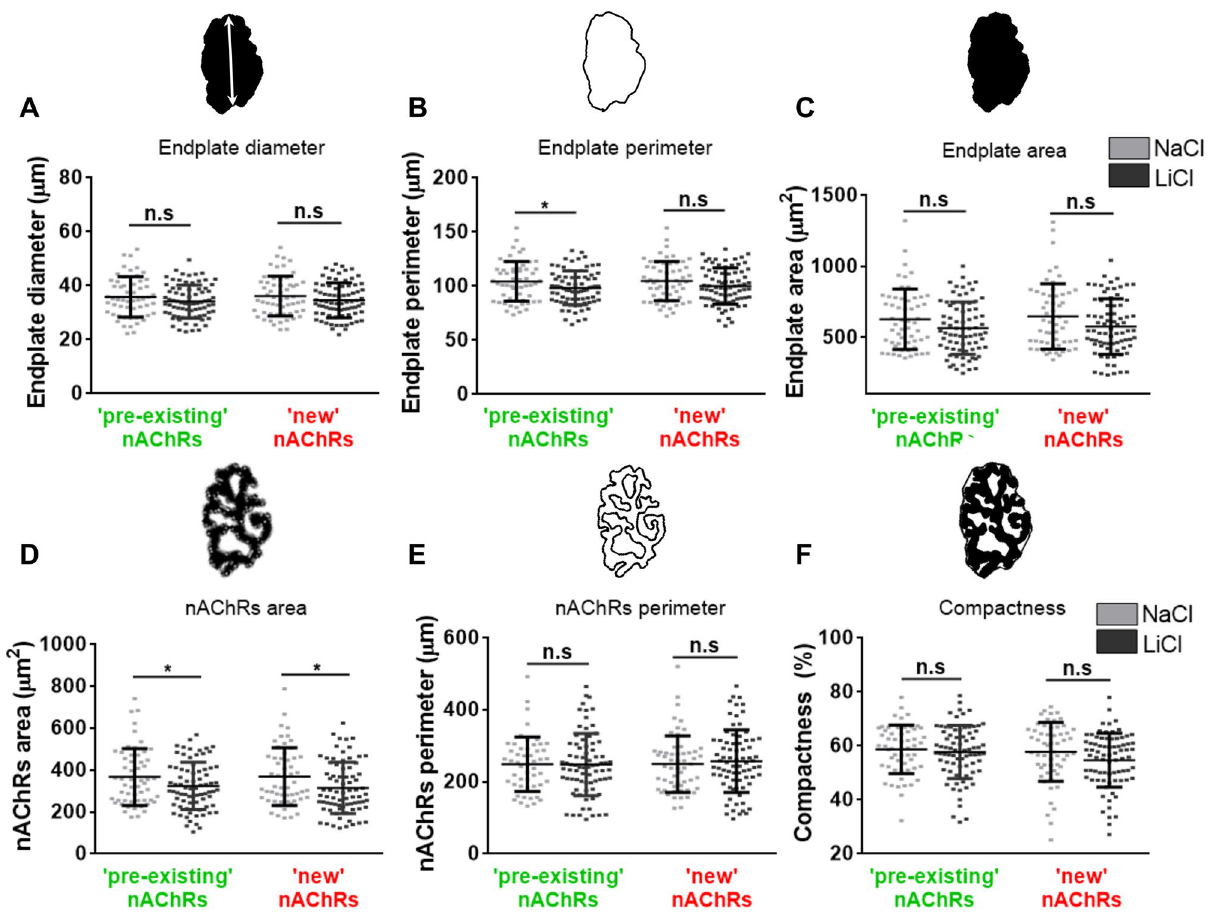
Figure 3. Postsynaptic NMJ morphology is not affected by lithium treatment. LAL muscles from control- or lithium-treated groups were subjected to the two-colour BTX assay. Images from BTX1 and BTX2 staining from lithium- and control-treated muscle samples were subjected to a systematic approach to perform morphometric analyses at the NMJ to determine postsynaptic parameters including endplate diameter ( A ), perimeter ( B ), and area ( C ). We also determined nAChRs morphological parameters, such as nAChR area ( D ), perimeter ( E ), and compactness ( F ). Graphs represent the mean values ± SD along with individual data from 30 to 40 NMJs per animal (N = 3 animals per group). t -test were performed for pre-existing (BTX1) or new (BTX2) nAChRs, respectively. * p < Lithium induces the aggregation of unstable nAChR clusters in denervated NMJs.